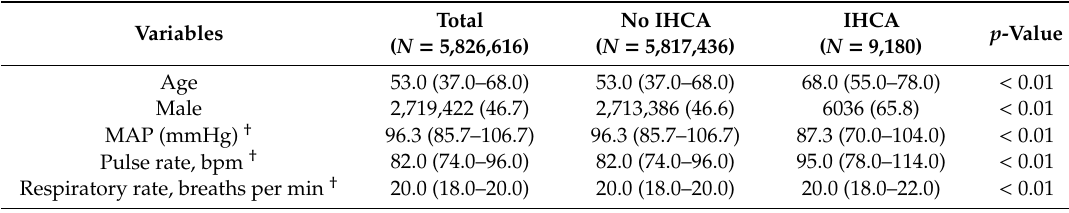
Table 1. Baseline demographic and clinical characteristics of emergency department patients with and without in-hospital cardiac arrest